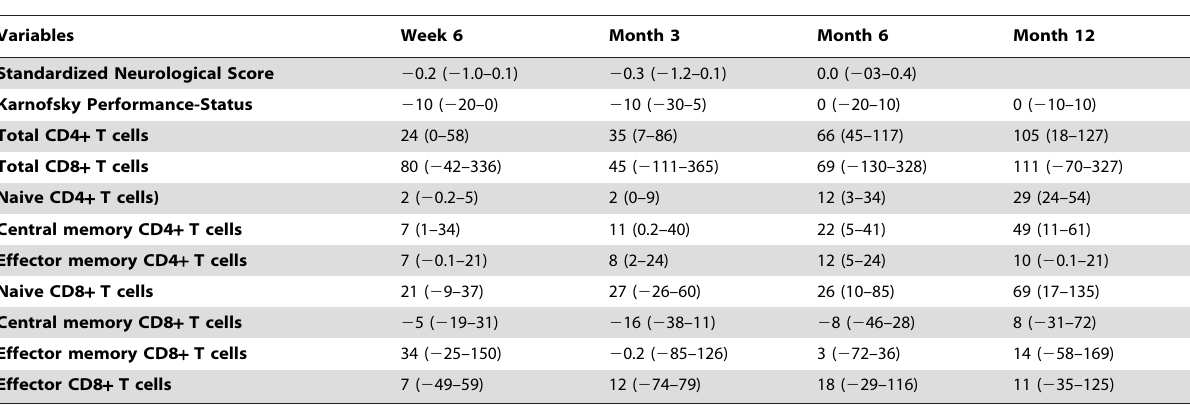
Table 2. Changes from baseline